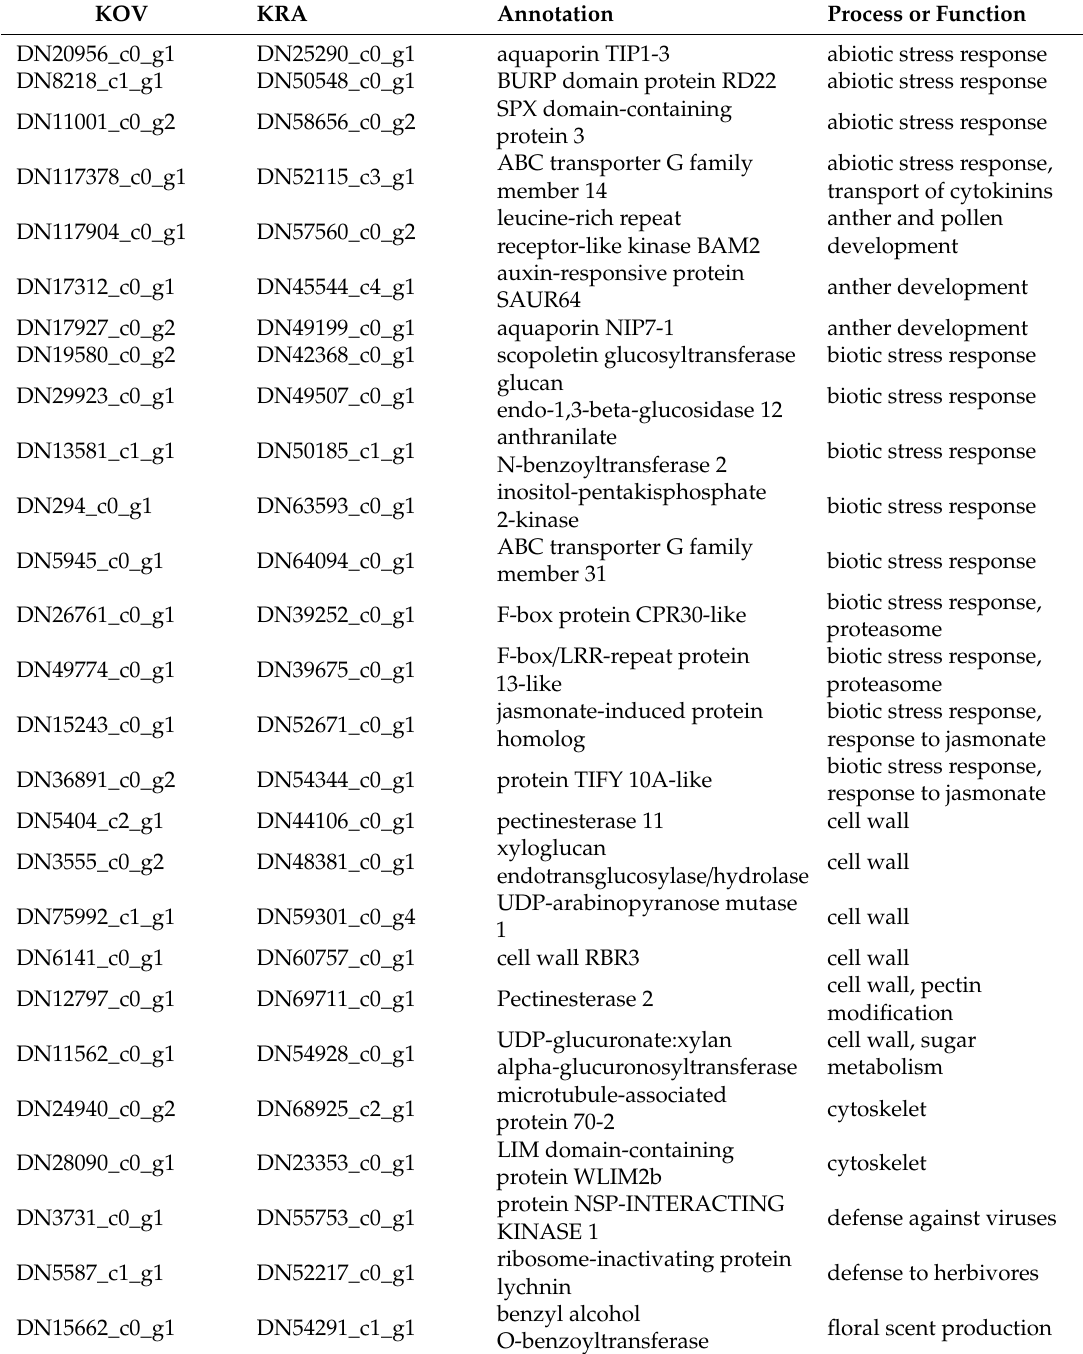
Table 3. Orthologous genes between the KRA and KOV haplotypes downregulated in F flower buds.